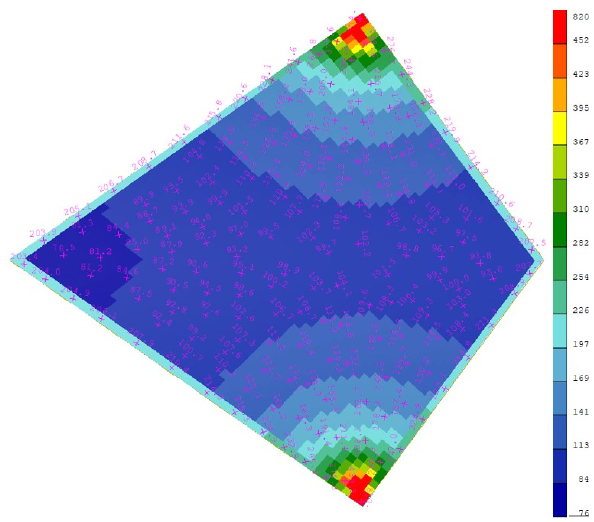
Figure 13: Thickness distribution of shell elements in model FE3 and